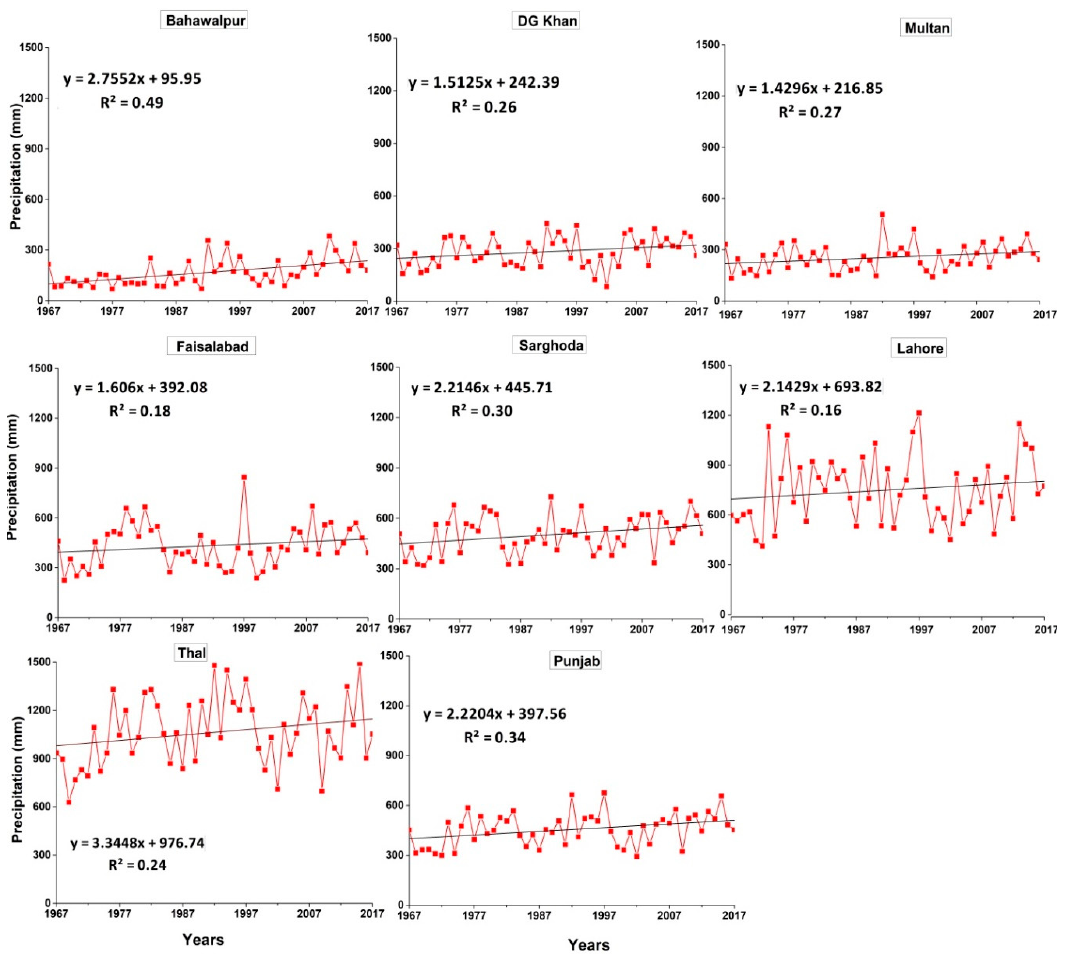
Figure 7. Time series and linear trend of annual precipitation in Punjab and the irrigation zones.